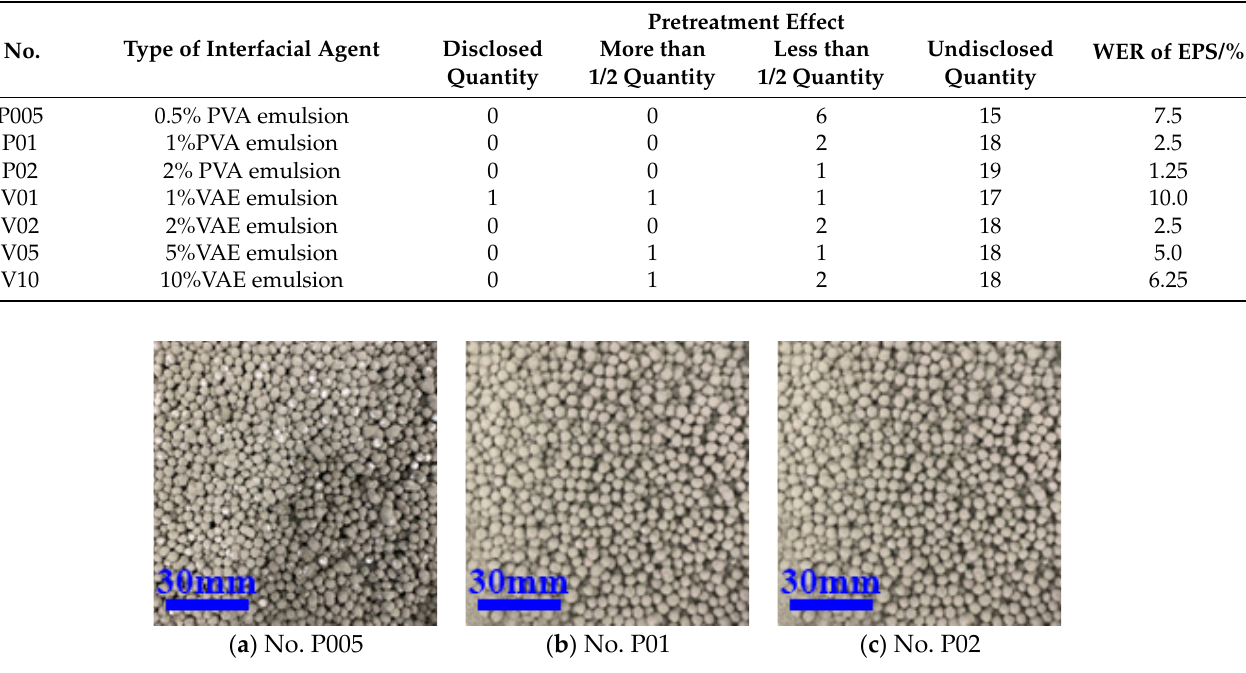
Figure 3. The exposure of CSLA after PVA emulsion treatment.